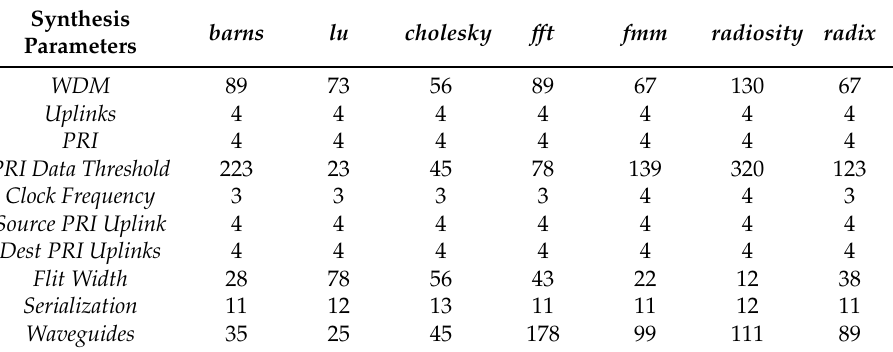
Table 6. Genetic Algorithm Synthesis